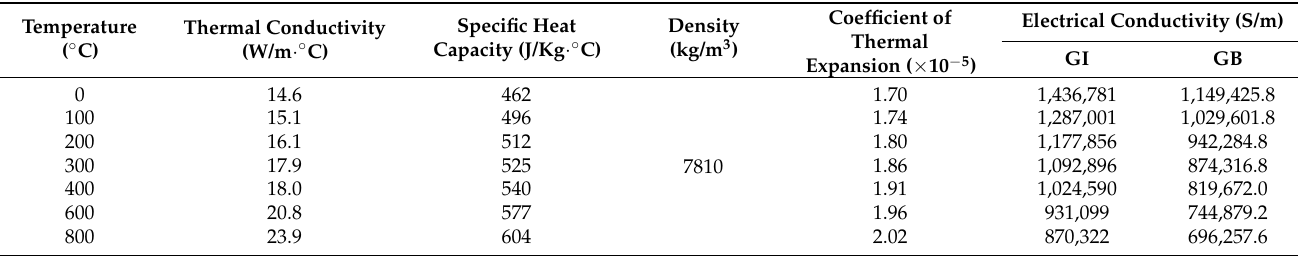
Table 1. Electrical and thermal properties of SUS304 [26].